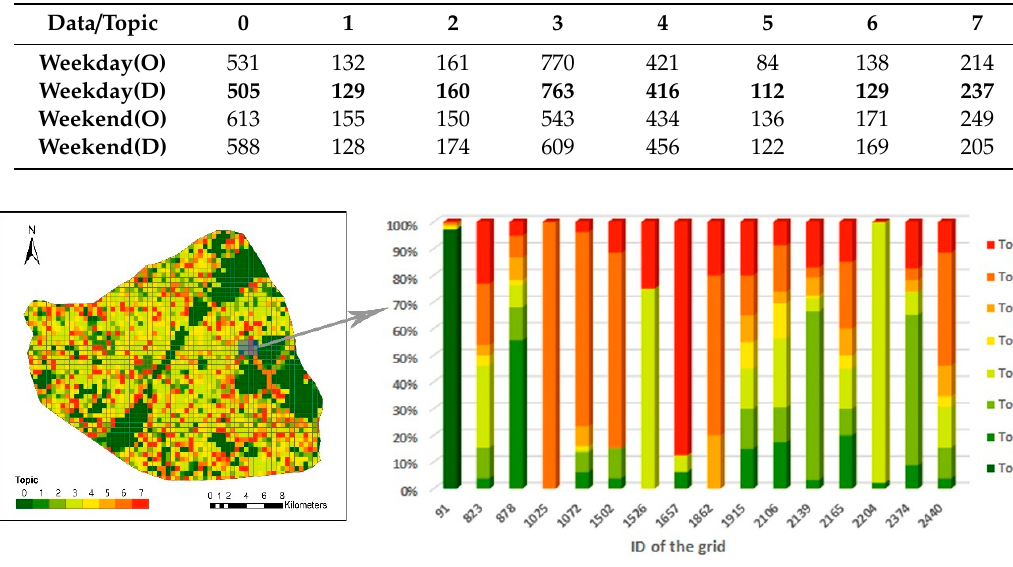
Figure 7. The proportion of different topics by the H-LDA model.